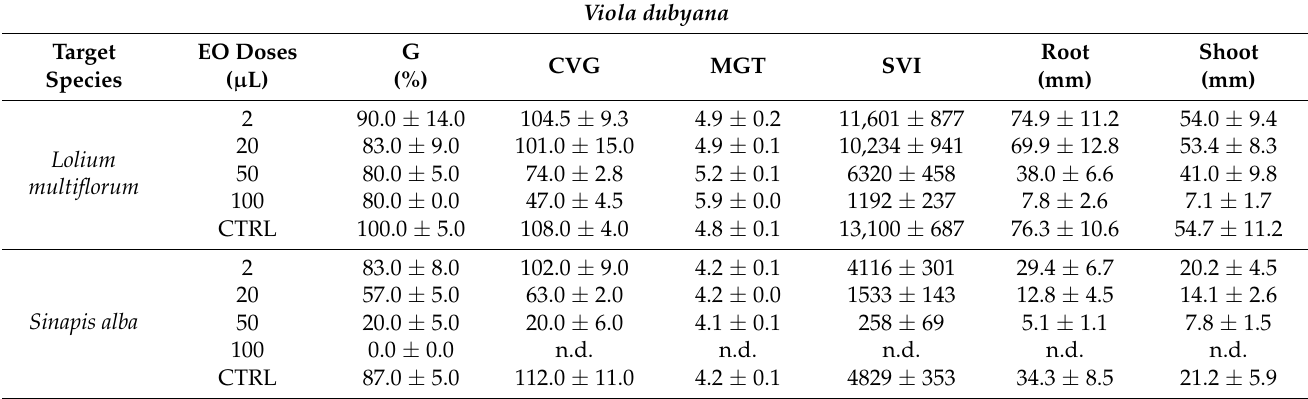
Table 4. Germination and growth parameters of two target species ( Lolium multiflorum and Sinapis alba ) under the phytotoxic effects of different doses of Viola dubyana